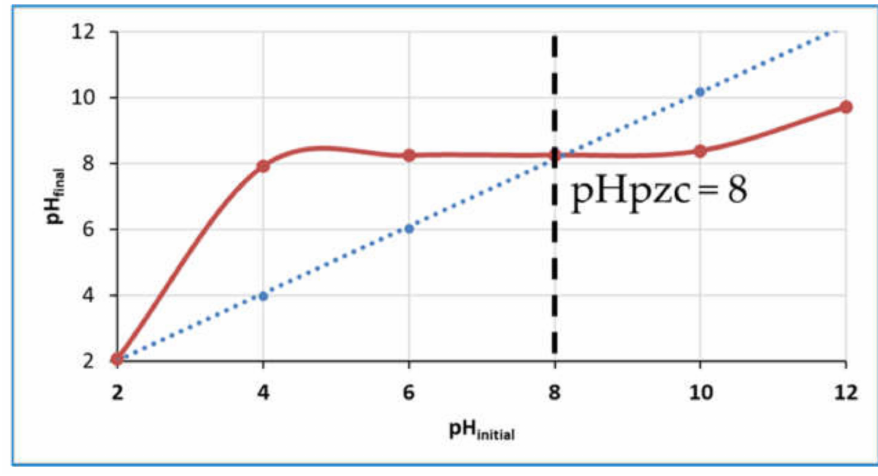
Figure 8. pH point of zero charge (pHpzc) plot of Mo (1.5 wt%)/SynTiO 2